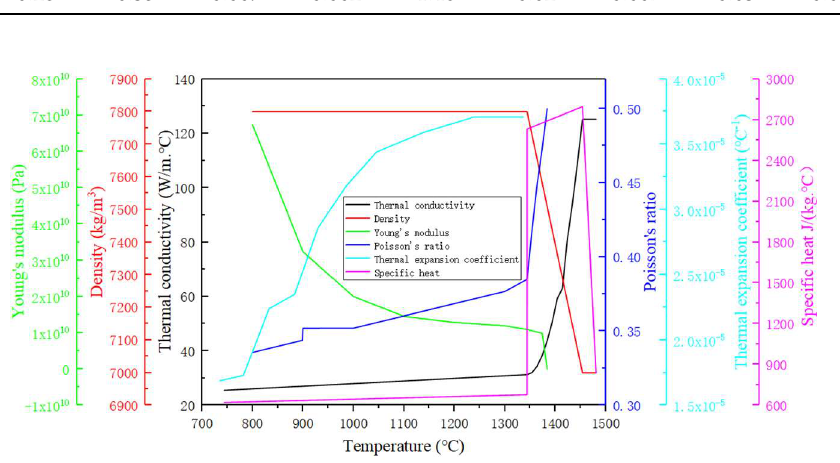
Figure 3. Physical parameters of the steel bearing GCR15.